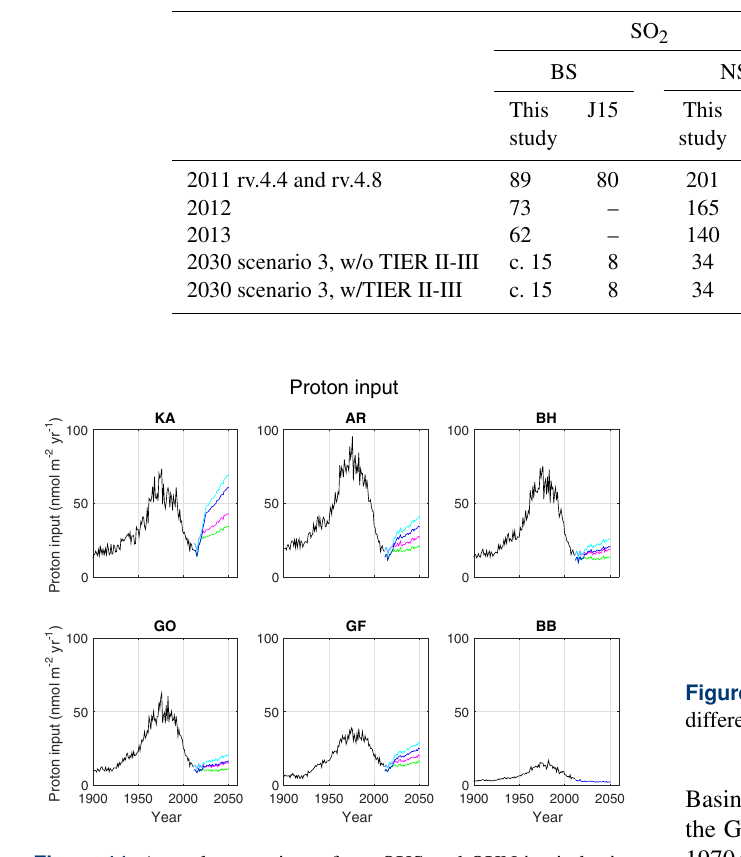
Figure 11. Annual proton input from OXS and OXN in six basins of the Baltic Sea (defined in Fig. 2) for the years 2010 to 2050. The red line corresponds with shipping scenario 3 and the magenta and cyan lines correspond with shipping scenarios 4 and 5, respectively (scrubber + atmospheric deposition). The black line shows histori- cal shipping (derived in Omstedt et al., 2015). The green and blue lines show the implementation of TIER II and a NECA and scrubber scenarios 4 and 5, respectively.